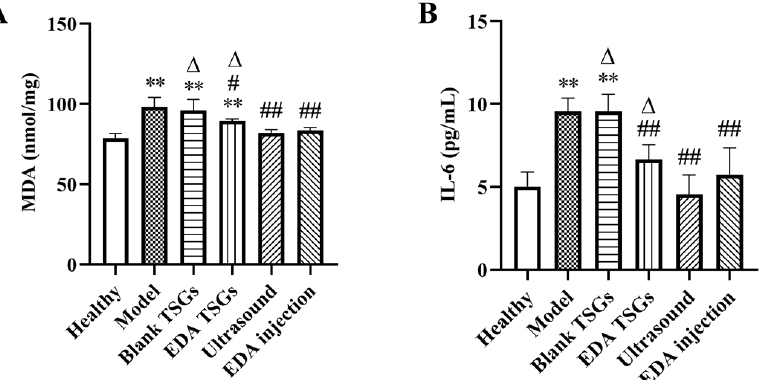
Figure 12. The decreased expression of MDA ( A ) and IL-6 ( B ) in hippocampus. Data are represented as mean ± SD ( n = 3). *: means significant difference, vs. the healthy group, ** p < 0.01; # : means significant difference, vs. the model group, # p < 0.05, ## p < 0.01; Δ : means significant difference, vs. the ultrasound group, Δ p < 0.05.